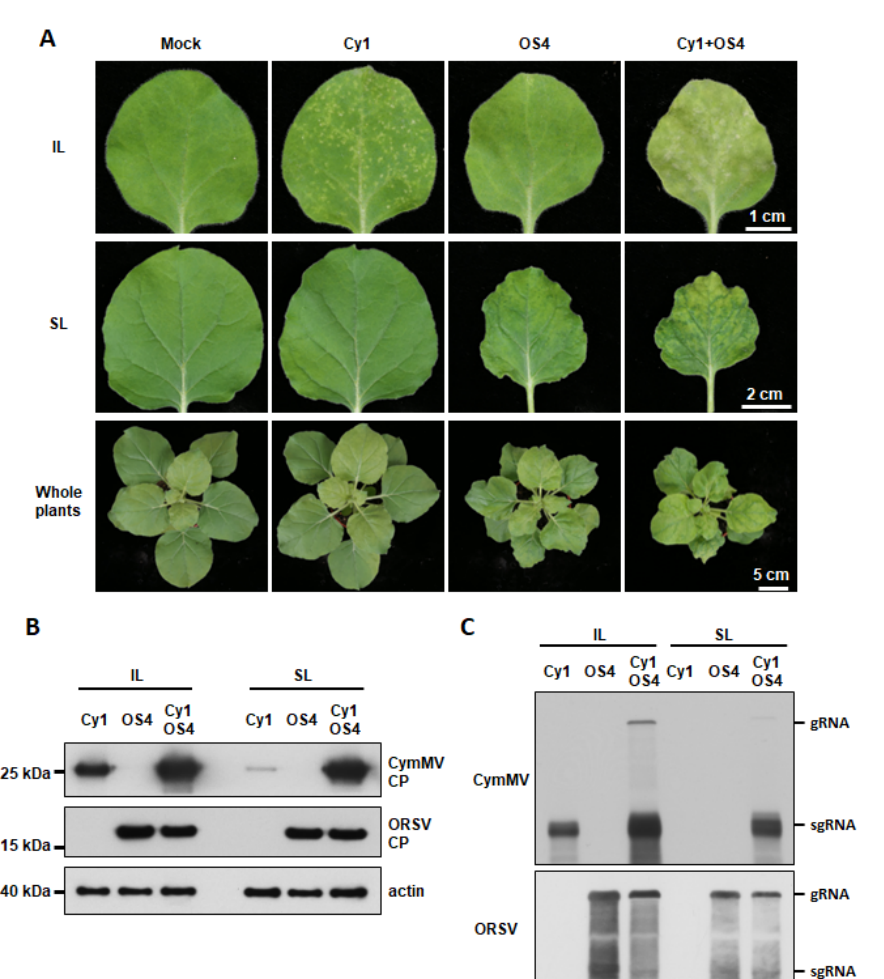
Figure 1. Cy1 and OS4 infectivity and synergism in inoculated N. benthamiana plants. ( A ) Symptoms and synergistic effects upon co-infection with Cy1 and OS4 virions. Eighteen-day-old N. benthamiana plants were individually inoculated with 0.5 μ g/leaf of Cy1 or OS4 virions or co-inoculated with 1 μ g/leaf of Cy1 and OS4 (0.5 μ g/leaf each). Symptoms on inoculated leaves (IL), systemic leaves (SL) and whole plants were photographed at 14 DPI. ( B ) Immuno-detection of Cy1 and OS4 CPs from leaf extracts of inoculated plants at 14 DPI using antibodies against the CP of CymMV or ORSV. Actin was detected by using anti-Actin monoclonal antibody as a protein loading control. ( C ) RNA blots for assessing Cy1 and OS4 viral RNA accumulation. Total RNAs were extracted from leaves as in ( B ). RNA was detected by using DIG-labeled probes against the CP and 3 (cid:48) UTRs of Cy1 or OS4,